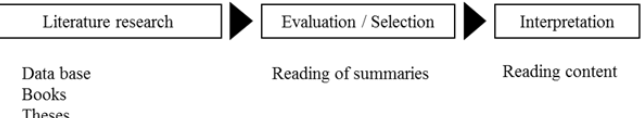
Fig. 1. Workflow of the